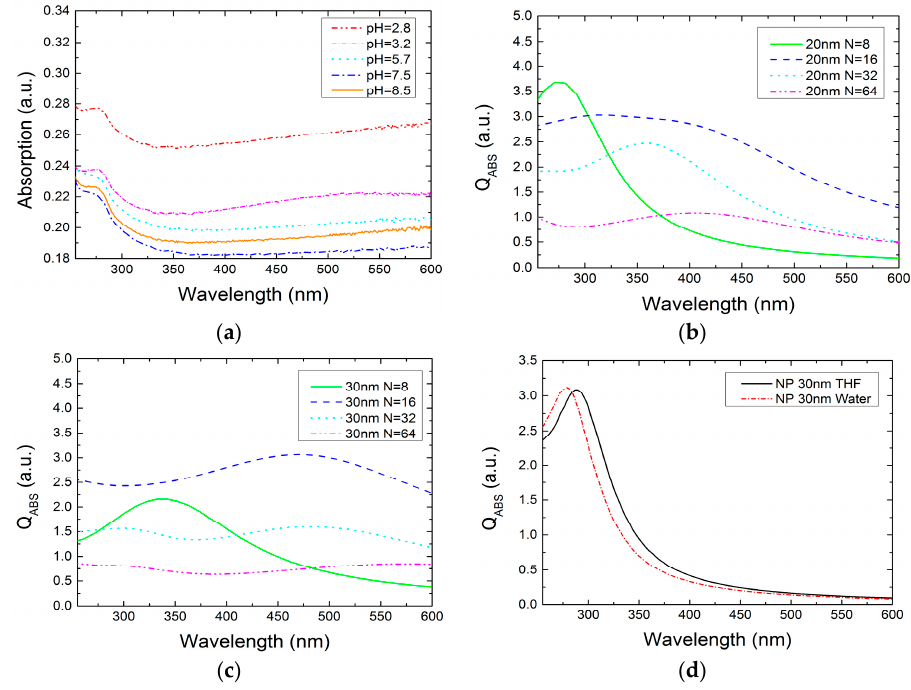
Figure 7. ( a ) Absorption measurements of aqueous colloidal solutions for different pH levels ranging from 2.8 to 8.5. Results of the simulations for NP clusters made of N number of agglomerated spheres with ( b ) 20 nm and ( c ) 30 nm diameter. ( d ) Calculated QABS of NPs in THF and aqueous solution.